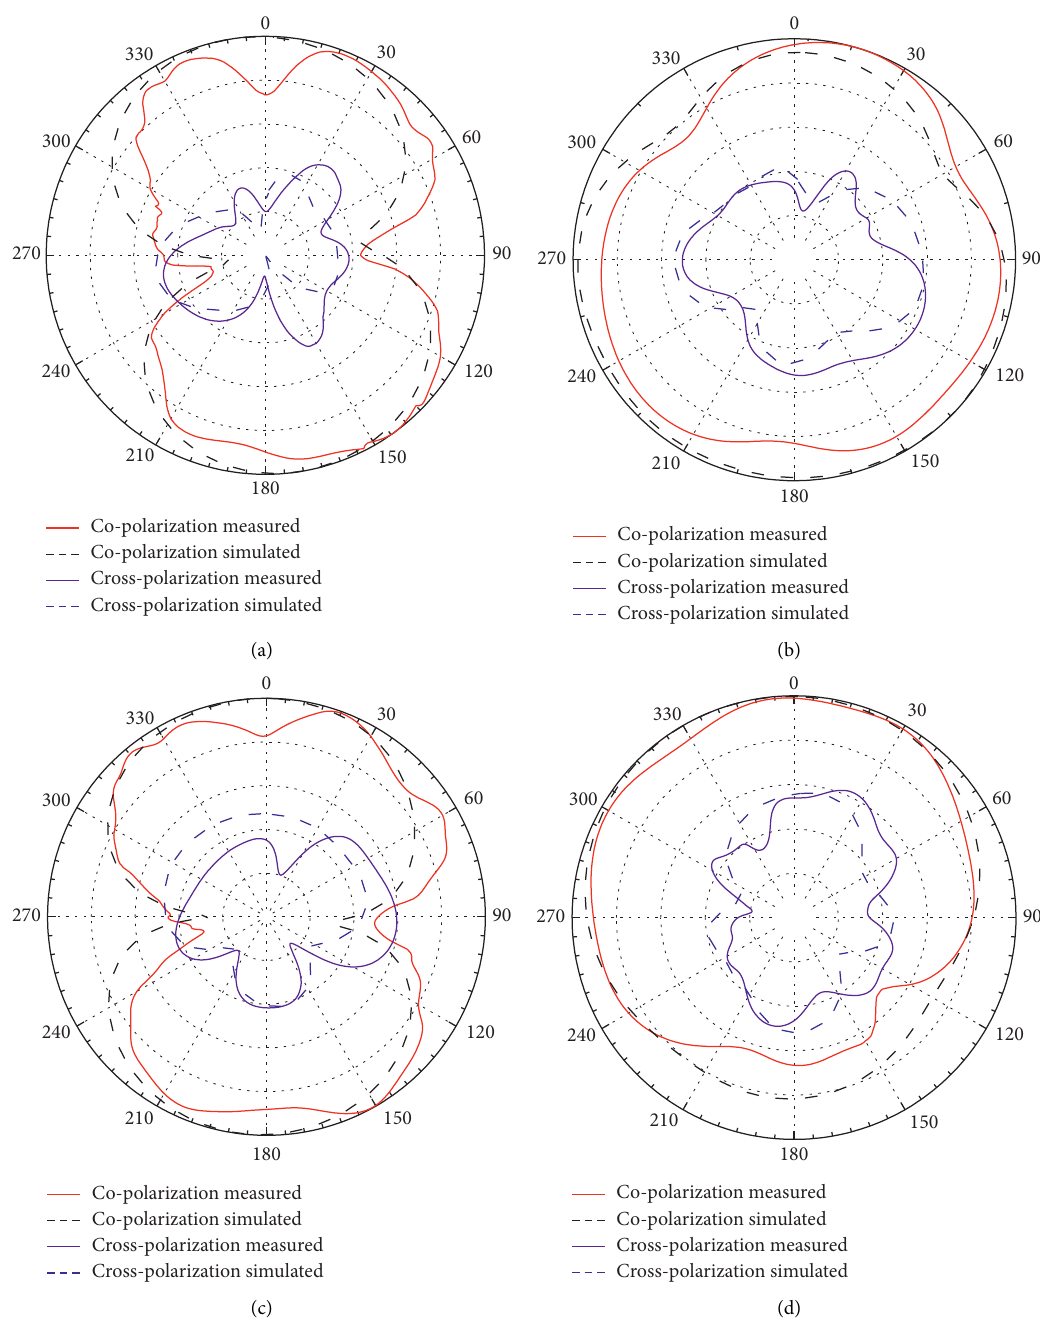
Figure 7: Measured and simulated radiation patterns of the proposed antenna: (a) 2.45GHz E -plane, (b) 2.45GHz H -plane, (c) 5.5 GHz E -plane, and (d) 5.5GHz H